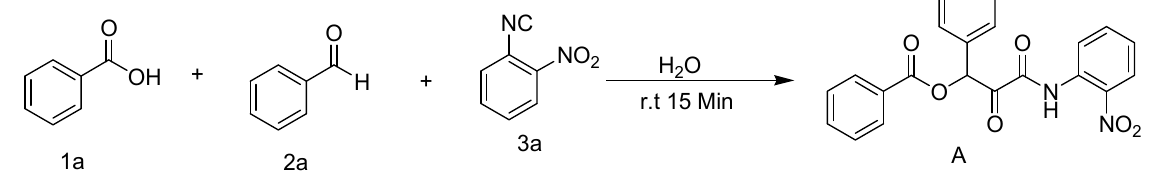
Table 1. Effect of different solvents on the scope of the Passerini reaction.